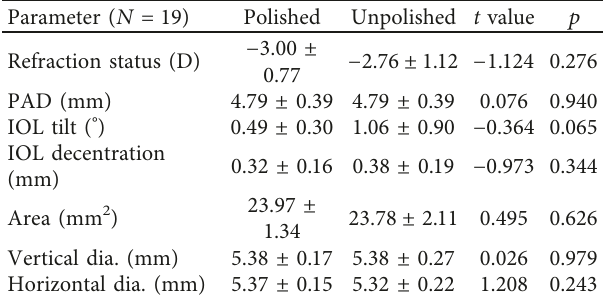
Table 2: Cross-sectional comparison between polished and un- polished groups at the 1 month after surgery.